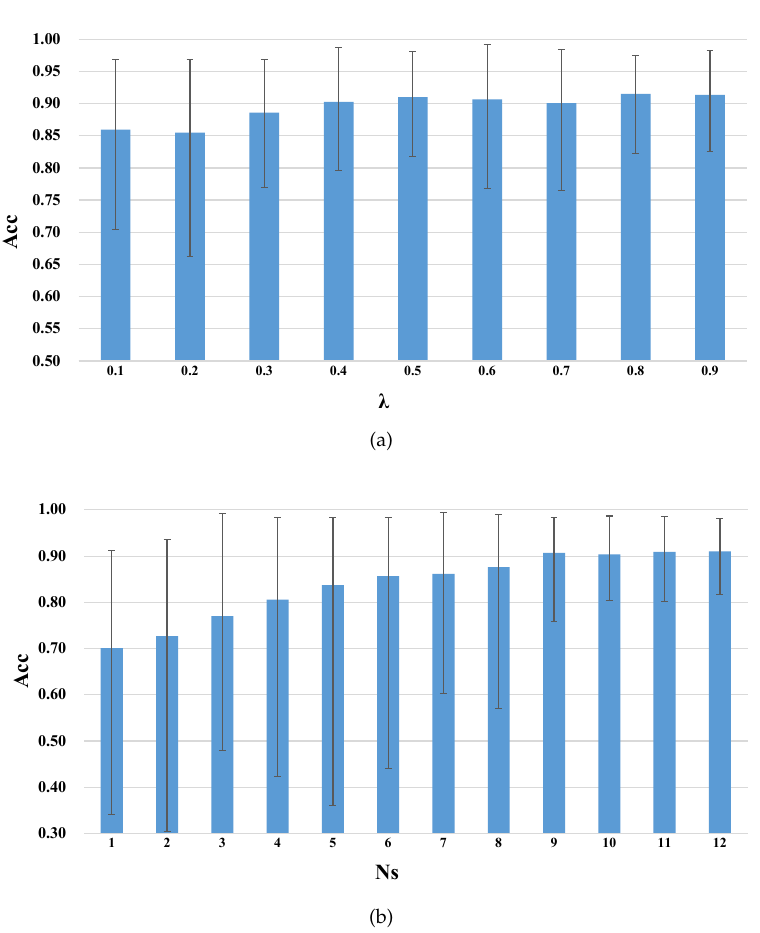
Figure 7. Parameter sensitivity of GDANN (( a ) shows the parameter influence of λ with N s = 12, and ( b ) shows the parameter influence of N s with λ =